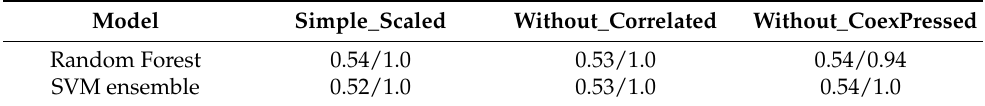
Table 1. Test/train cross-validation accuracy for ensemble models. Random Forest and SVM ensemble models were applied to simple scaled (simple_scaled), without correlated genes (with- out_correlated), and without co-expressed genes (without_coexpressed) datasets. Both Random Forest and SVM ensemble models failed to generalize on each of the datasets.